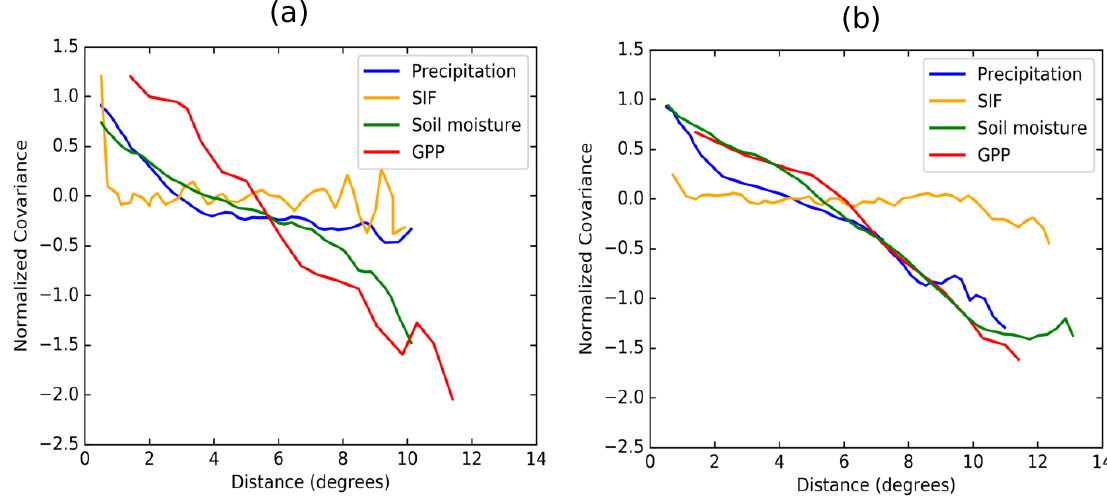
Figure 2. Covariogram of SIF, precipitation, soil moisture, and GPP data over ( a ) the Great Plains and ( b )